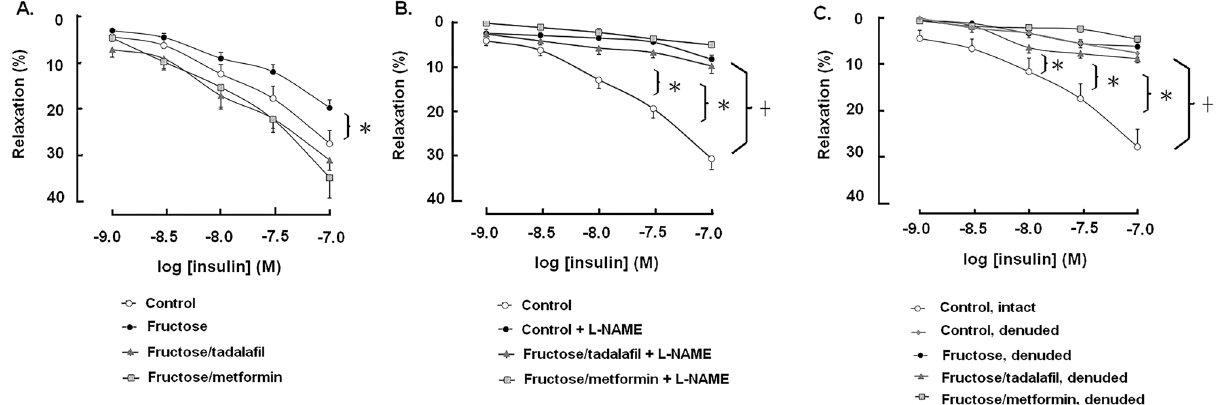
Figure 2. The response curves of relaxation of detrusor muscle in response to insulin (1–100 nM) stimulation in mucosa-intact (n = 8) ( A ), L-NAME-treated (n = 8) ( B ) and mucosa-denuded (n = 6) ( C ) bladder strips of control or fructose fed animals, alone or with addition of L-NAME, tadalafil or metformin. Data are expressed as mean ± SEM. *p < 0.05 in comparison with the control group by one-way ANOVA with Dunnett’s test, and ✝ p < 0.05 in paired t -test. In all experiments, the bladder strips were pre-contracted by the incubation of KCl (80 mM). The means of KCl-induced contractility in the control group are 1.118 g/mm 2 ( A ), 1.194 g/mm 2 ( B ), and 1.095 g/mm 2 ( C ),